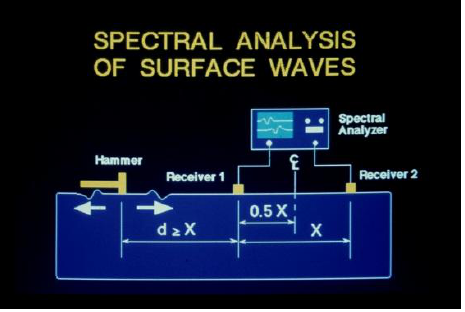
Figure 5. SASW Process (Diagram courtesy of Olson Instruments) Ultrasonic Pulse Velocity (UPV): Measures velocity of an ultrasonic pulse through concrete to determine strength and integrity. Faster velocity typically correlates to material with